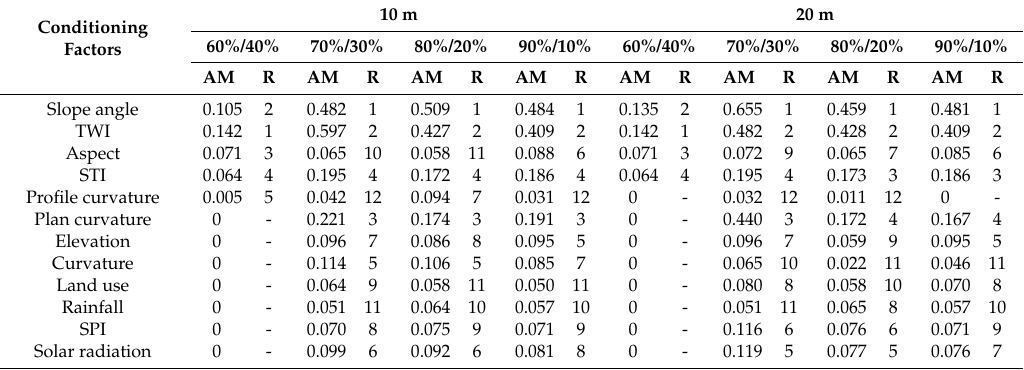
Table 2. Factor selection based on the information gain ration